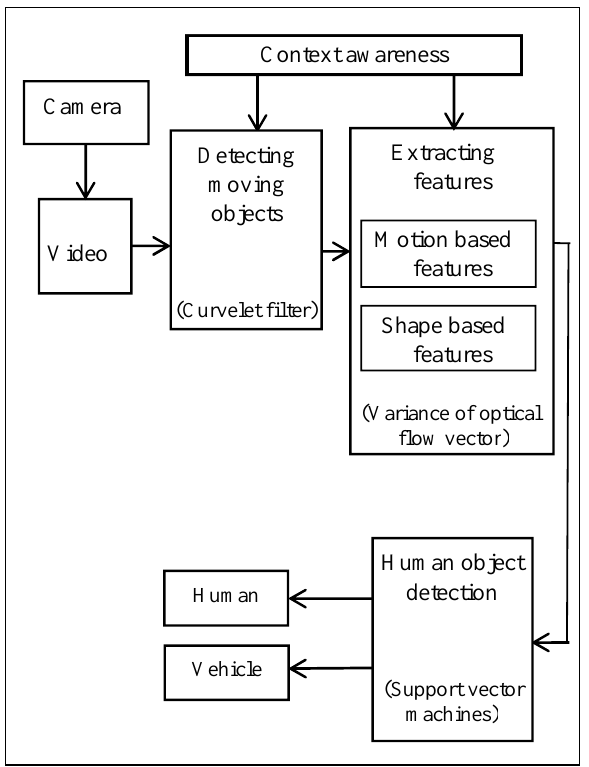
Figure 2. The overall of the proposed method for object